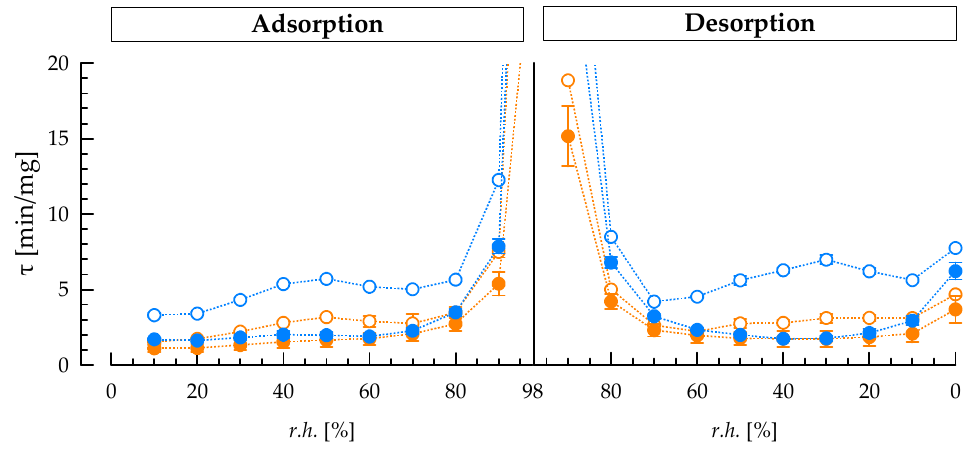
Figure 4. Sorption time τ of S. thermophilus ST-1G (blue) and ST-2E (orange) cell isolates with attached cEPS (closed symbols) and fEPS (open symbols) as a function of relative humidity r.h. during adsorption and desorption.